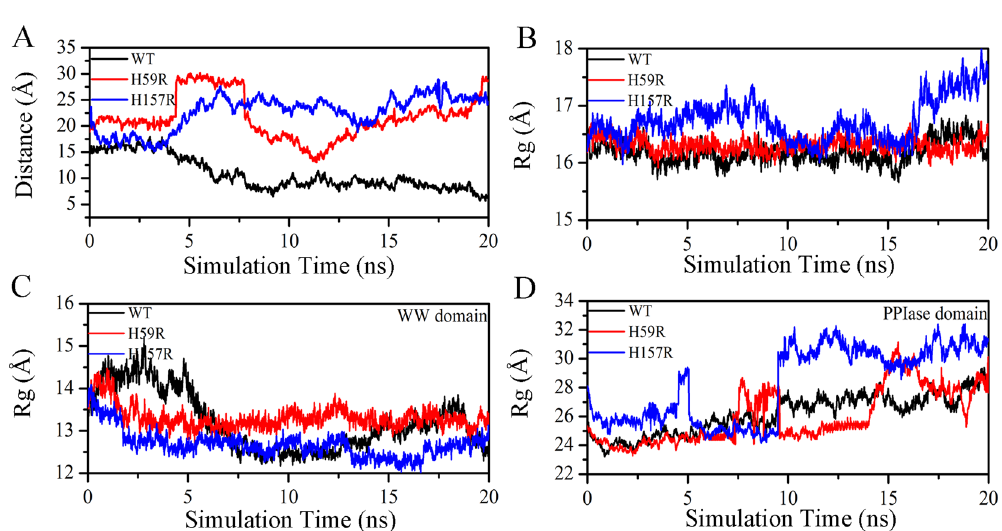
Figure 8. The distance and Rg result in Pin1-WT, H59R and H157R as a function of 20 ns MD simulation. ( A ) The distance between the WW and PPIase domain as a function of 20 ns MD simulation. ( B – D ) Represented Rg of the overall structure, PPIase and WW domain,